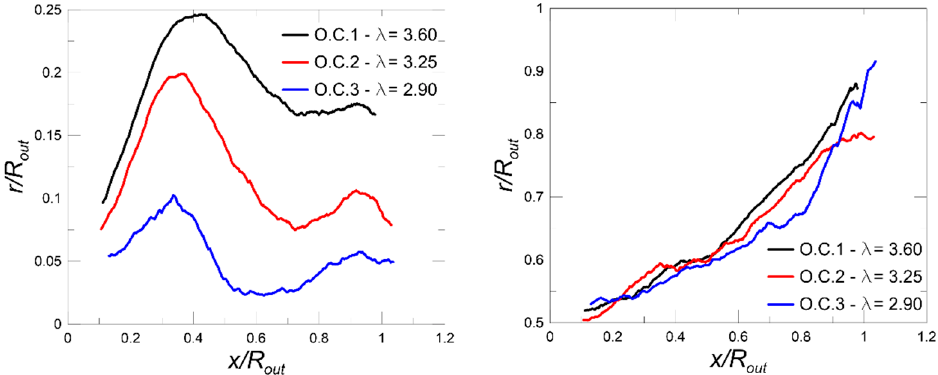
Figure 11. Most probable location of flame fronts within the IRZ ( left ) and on the inner shear layer ( right ).